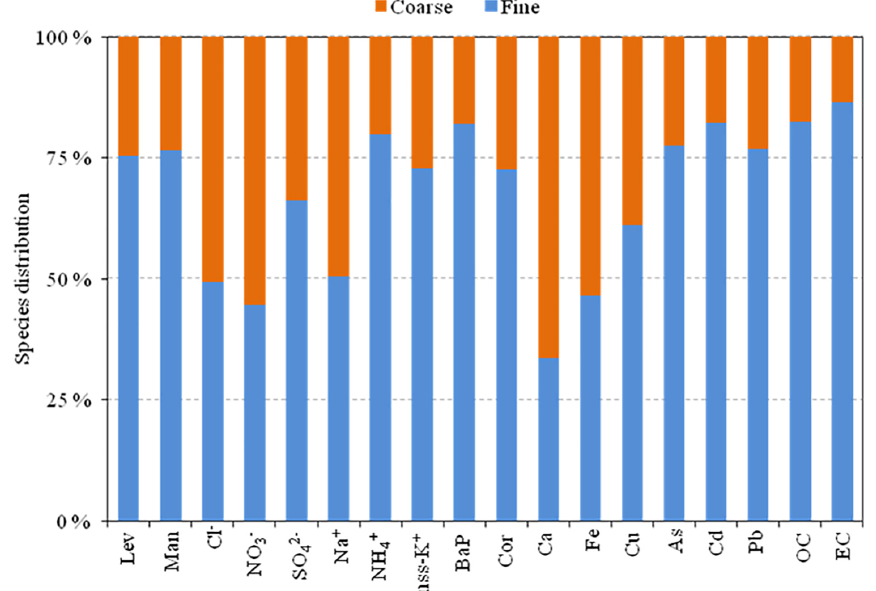
Figure 8. Mass percentage distribution of species in the fine and coarse